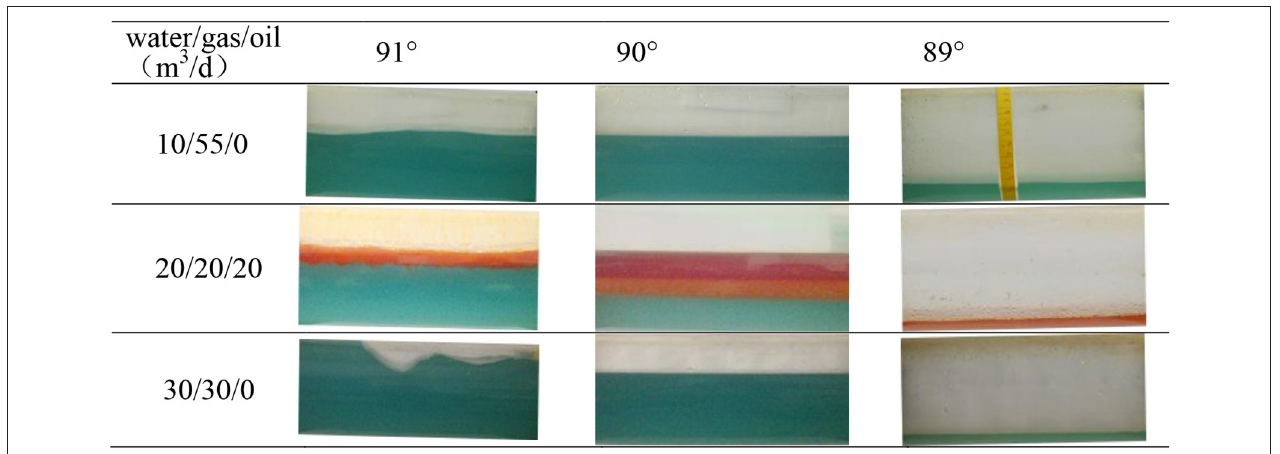
FIGURE 2 | Experimental Images of the Multiphase Flow within a Horizontal Well.